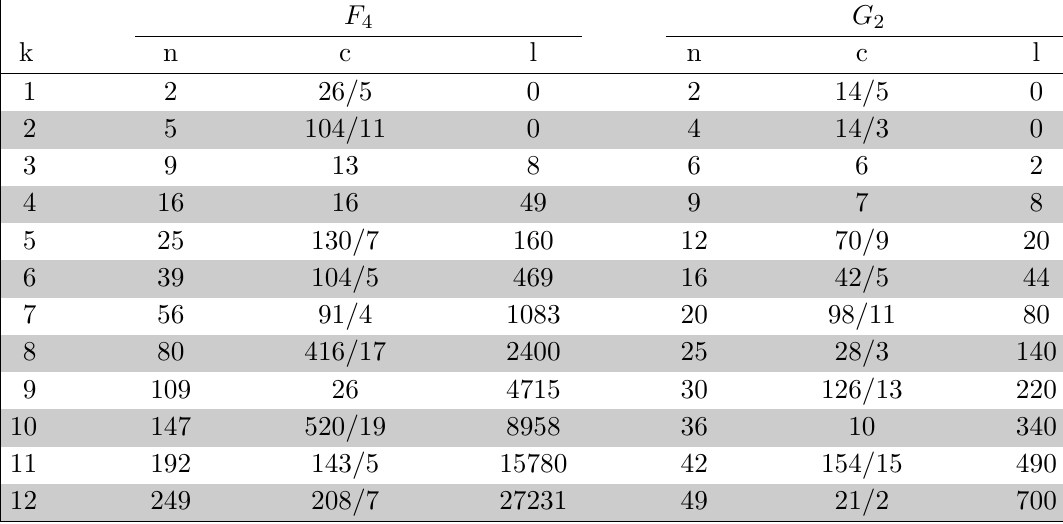
Table 5 . Exceptional